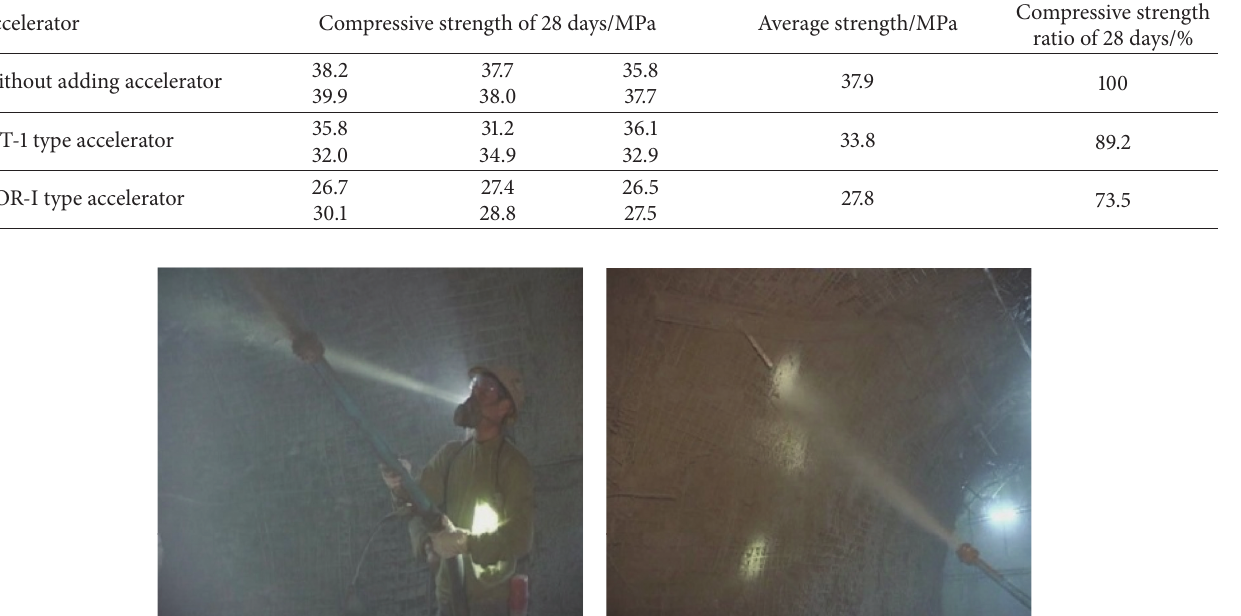
Figure 8: The site of wet